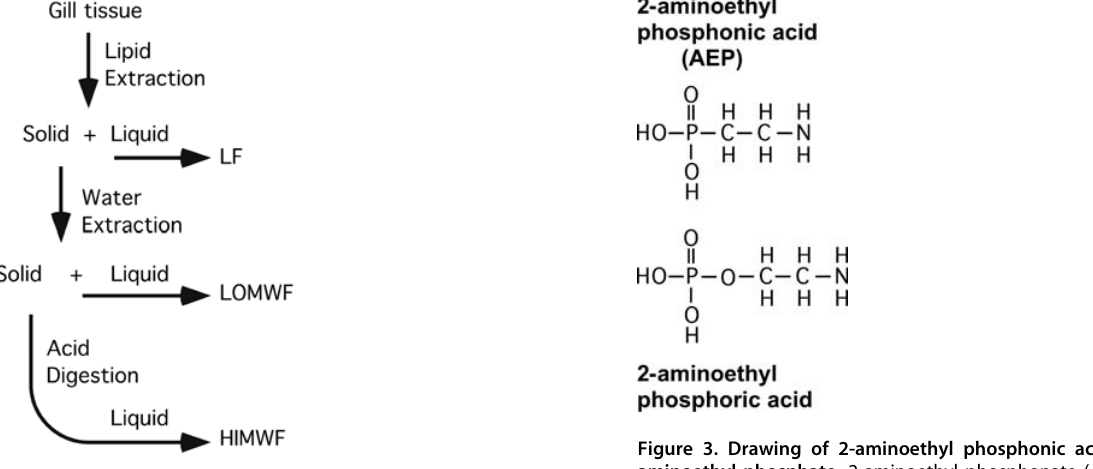
Figure 2. Flow diagram of gill extraction procedure. Flow diagram of gill tissue fractionation using vigorous blending with the solvent (chloroform:methanol 2:1) to extract the Lipid Fraction (LF). The remaining solid was then vigorously blended with water to extract the Low Molecular Weight Fraction (LOMWF). The remaining solid was digested with concentrated hydrochloric acid at 104 degrees C for 24 hours to hydrolyze any phosphorus incorporated into high molecular weight polymers. This hydrolysis yields small soluble phosphorus compounds observable by P-31 NMR. Any AEP incorpo- rated into polymers would be released as free AEP. Free AEP is not